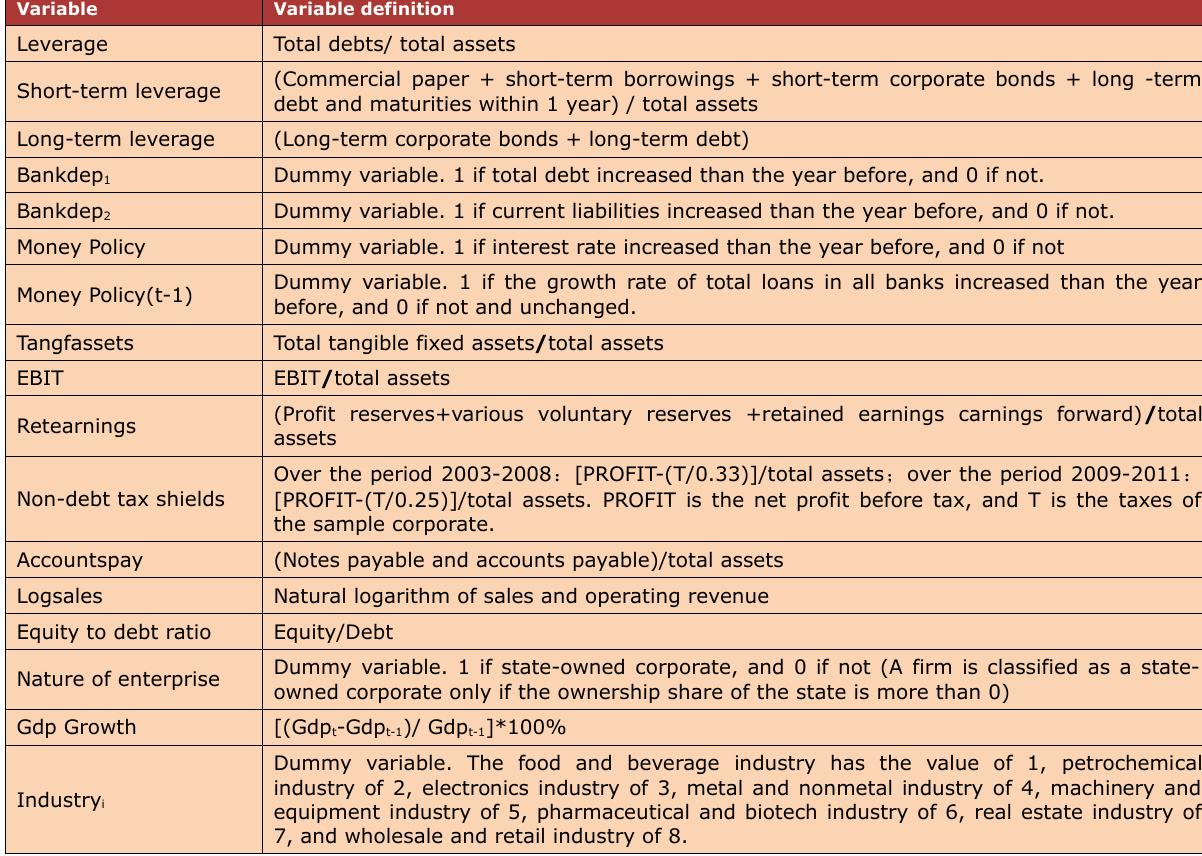
Table 2. Variables